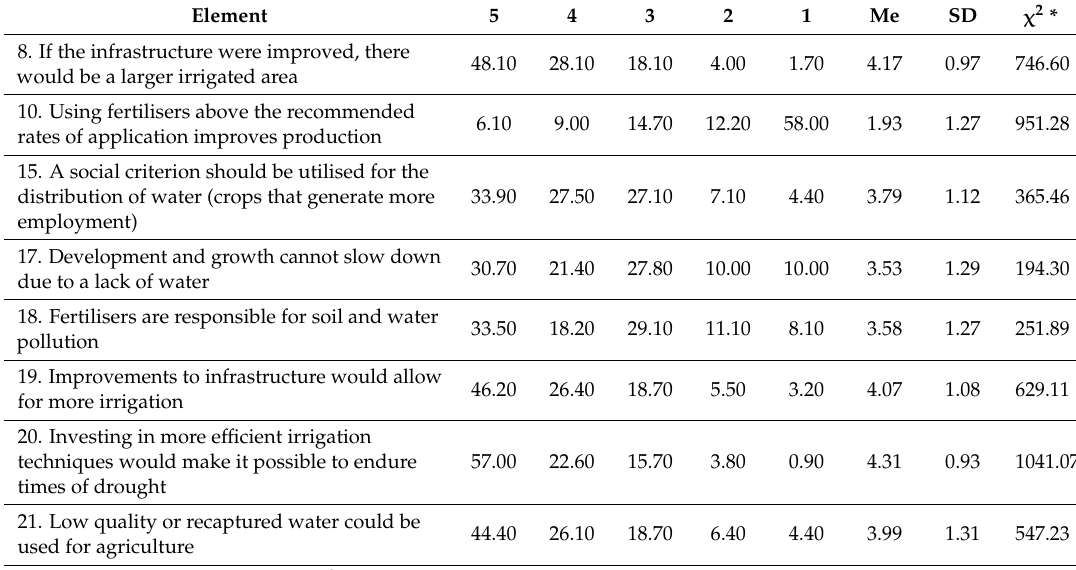
Table 3. Results of the emotive